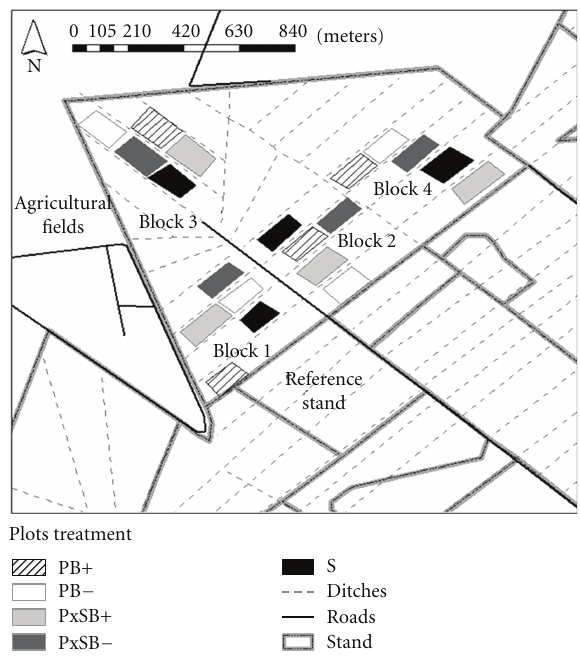
Figure 1: Map of study area, established and maintained by Catch- light Energy LLC, located in timberlands owned and managed by Weyerhaeuser Company in Lenoir Co., NC. Treatments: PB+ = Pine Biomass+; PB − = Pine Biomass − ; P × SB+ = Pine × Switchgrass Biomass+; P × SB − = Pine × Switchgrass Biomass − ; S =